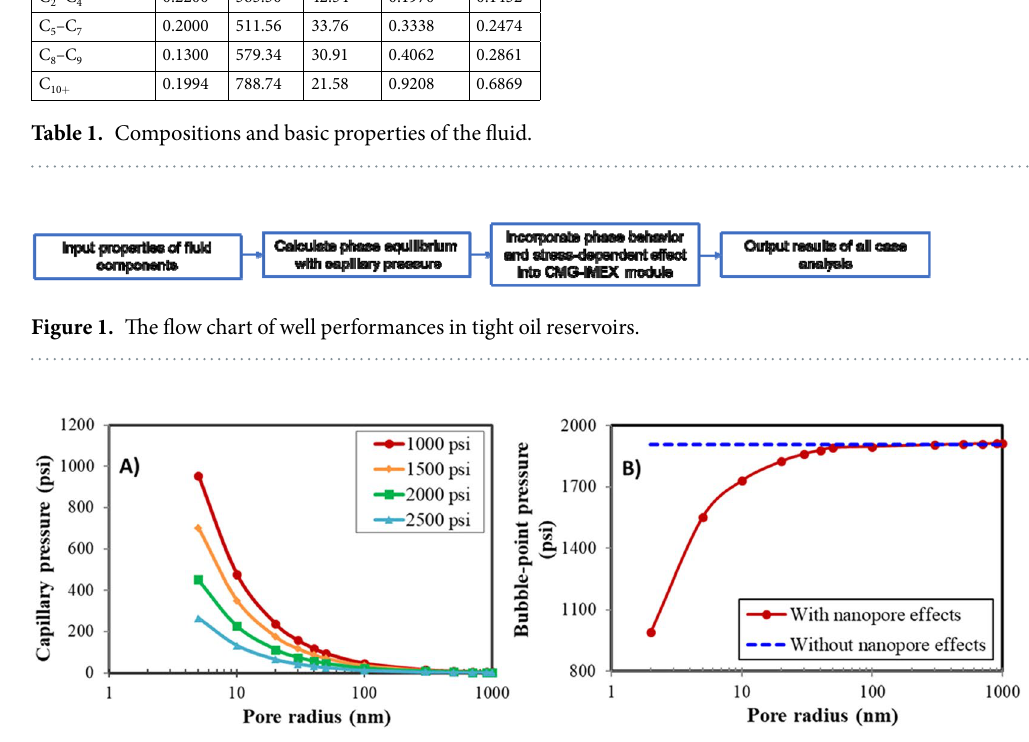
Figure 2. Capillary pressure and bubble-point pressure under different pore sizes. ( A ) Capillary pressure. ( B ) Bubble-point